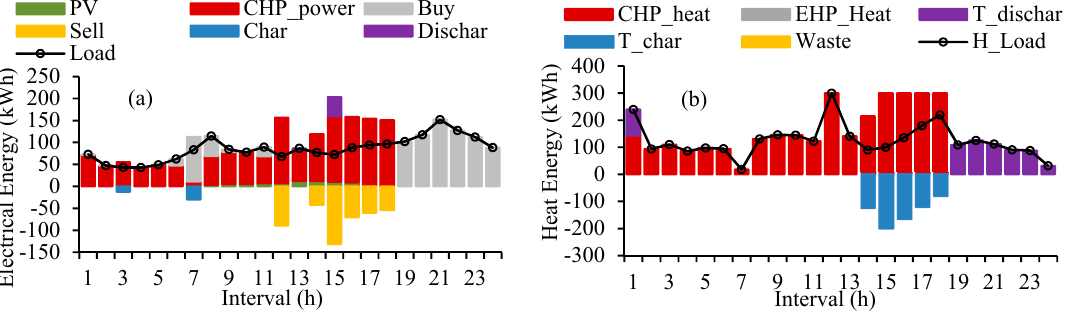
Figure 13. Energy balance in winter: ( a ) power; and ( b ) heat energy.